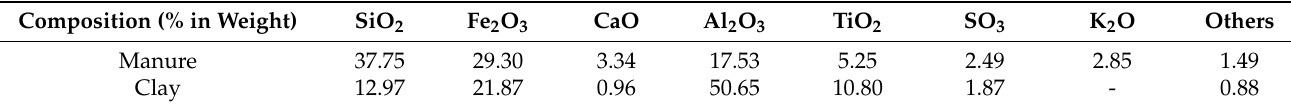
Table 2. Chemical composition of clay and manure.